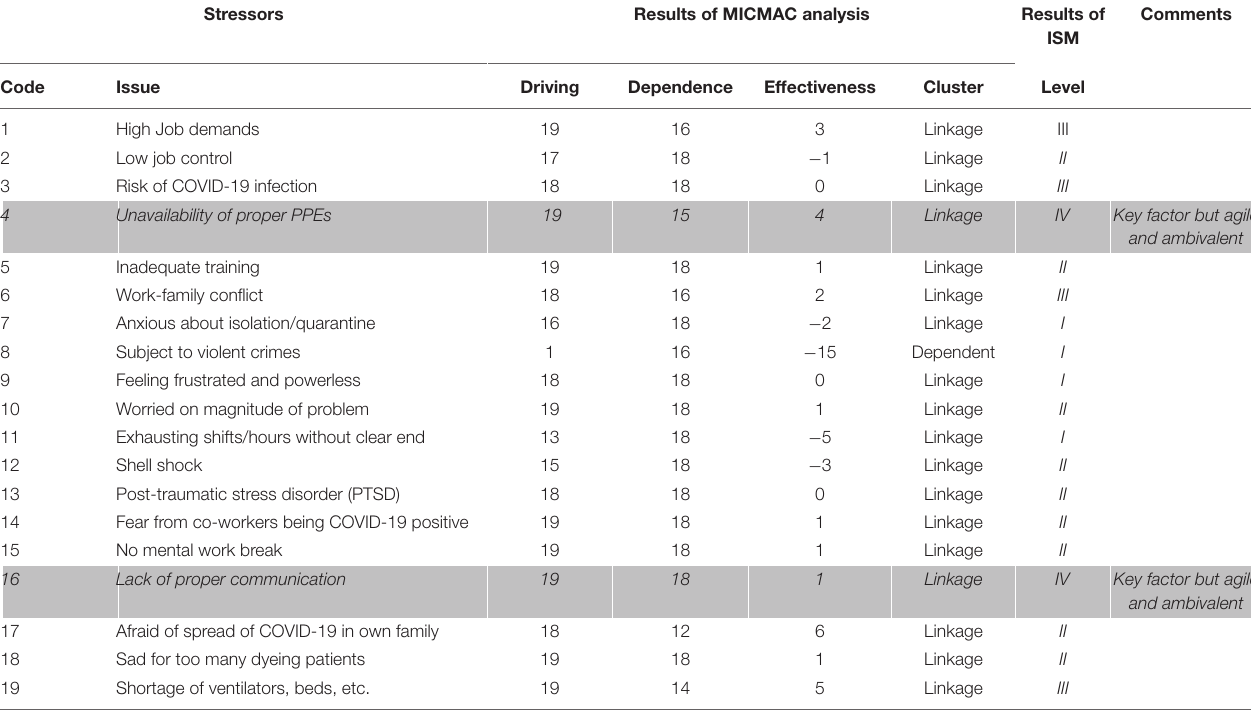
TABLE 6 | Juxtaposed results of cross-impact matrix multiplication applied to classification (MICMAC) and interpretive structural modeling (ISM).